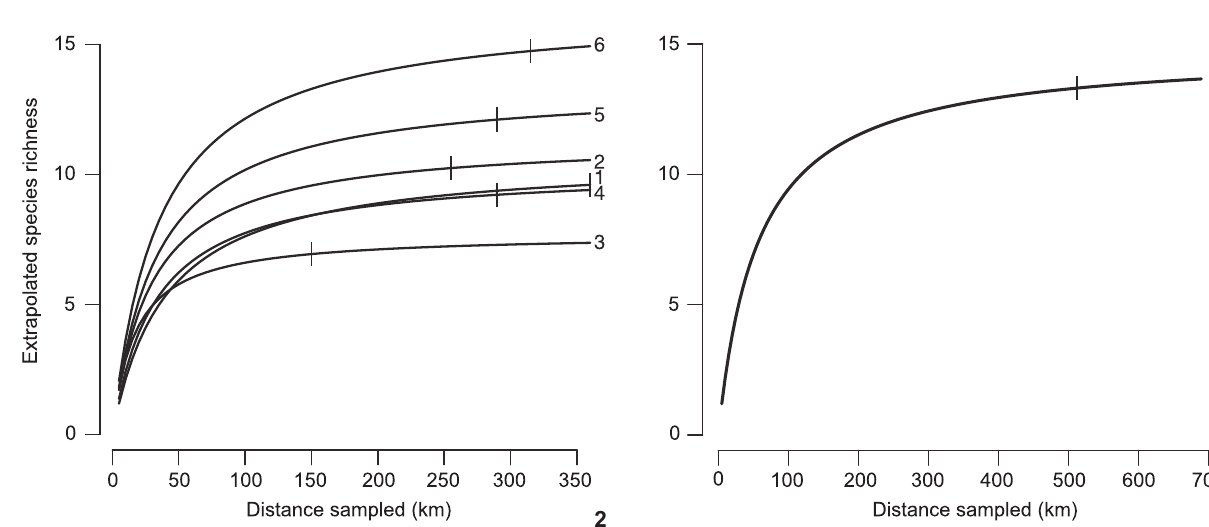
Figures 2-3. Species accumulation curves based on mammal surveys carried out monthly throughout 1-year in six transects at Maracá Ecological Station, Roraima, Brazil. Extrapolated species richness fitted to asymptotic Clench model is shown in y axis. Cumulative distance is shown in x axis. Vertical bars indicate the theoretical effort required to achieve survey completeness (see Table I). (2) Each curve represent one transect, identified by numbers after the curves. (3) Curve representing all transects pooled (landscape level). Note that the lengths of x axes